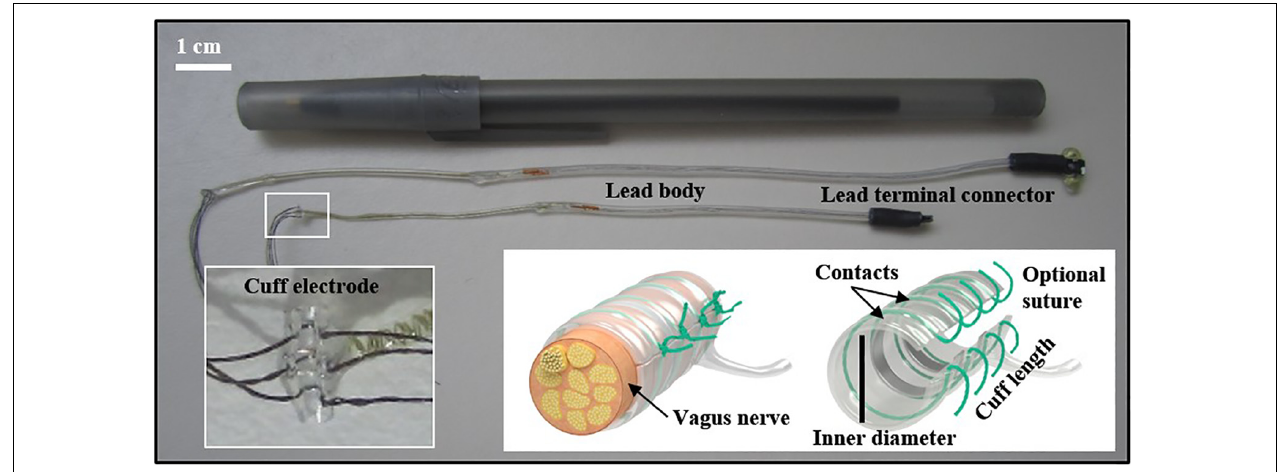
FIGURE 1 | Different sized (0.3 and 0.5 mm) cuff electrodes with connectors. Embedded sutures on the electrode can facilitate the surgical implant (inset). Other important electrode elements described in the text are identified. Cuff image reproduced with permission from MicroProbes for Life Science (Gaithersburg,